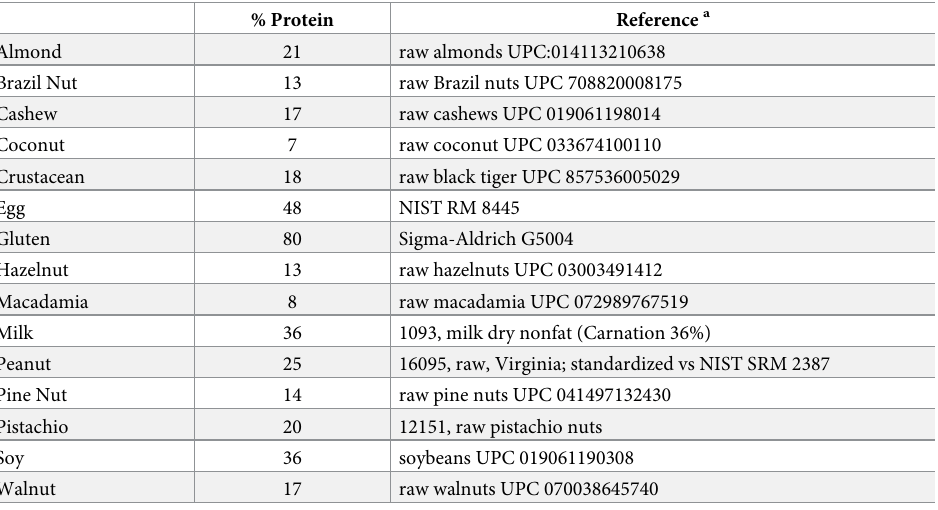
Table 2. Protein content of allergenic foods used as